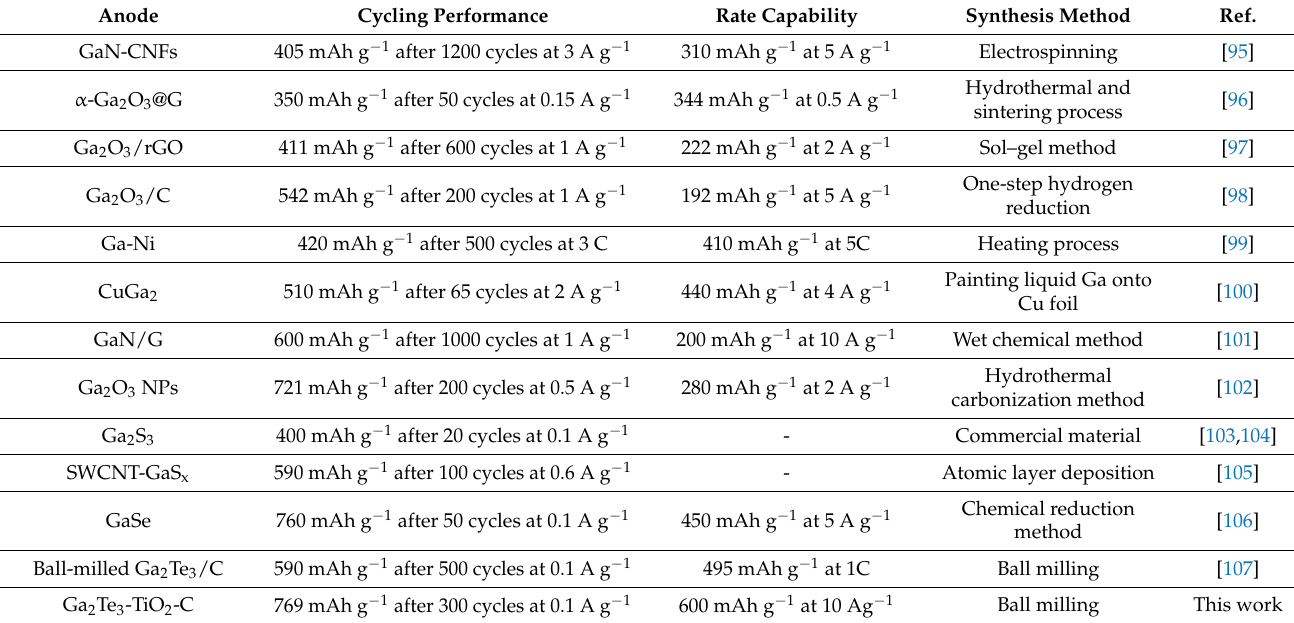
Figure 7. Schematic of reaction mechanism of Ga 2 Te 3 -TiO 2 -C (10%). Table 1. Performances of Ga-based intermetallic electrode for LIBs.